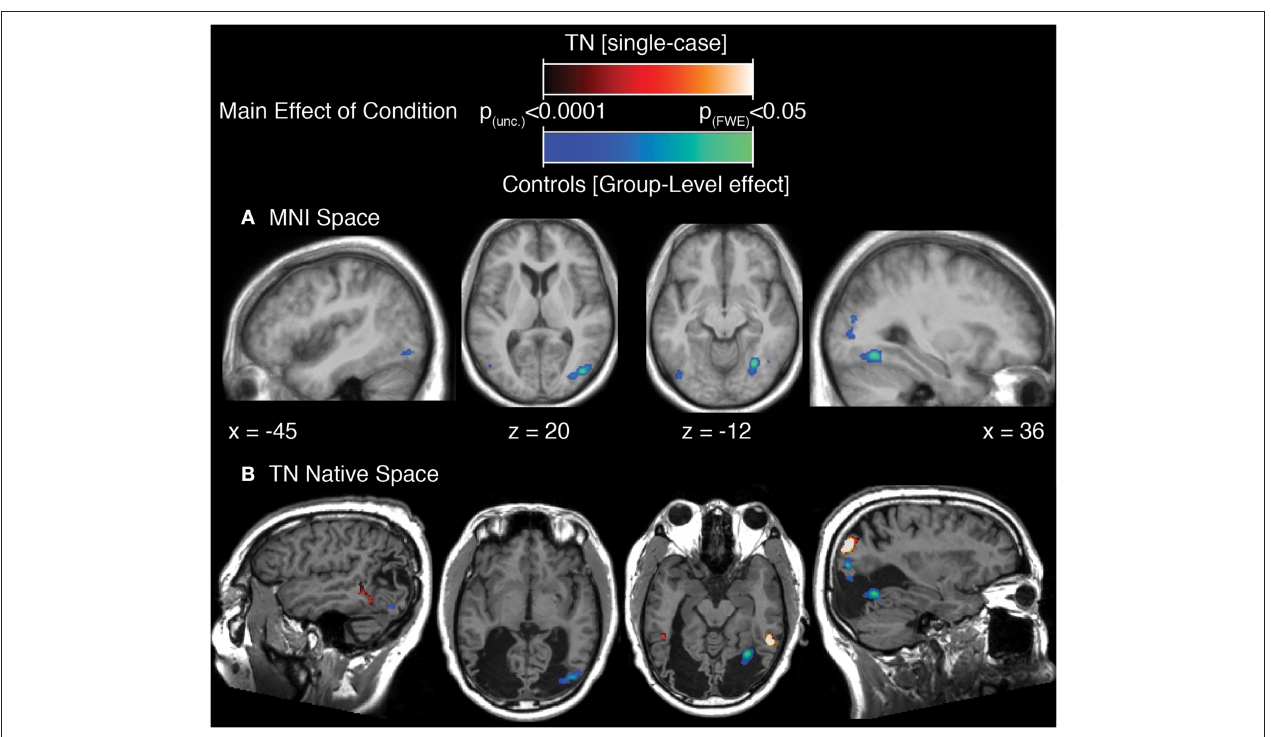
FIGURE 3 | (A) Main effect of condition in the control participants (repeated-measures ANOVA, four levels: Loom, Recede, Rotate, Static), showing significant differences in BOLD response thresholded at p (uncorrected) < 0.0001, with a cluster extent threshold ( k ) of 70 voxels. This value of k was empirically determined to be the level for which clusters composed of voxels at least meeting uncorrected p < 0.0001 would reach familywise-error corrected significance at the cluster level. Data are projected onto the average T1 structural image of the control participants, normalized to MNI space. Co-ordiantes indicate plane of section of each slice. (B) The main-effect of condition in the control participants as in (A) , but projected into TN’s native space, displayed upon TN’s T1 structural scan, and presented alongside the map of significant main effect of condition for TN (thresholded as for controls, k was determined to be